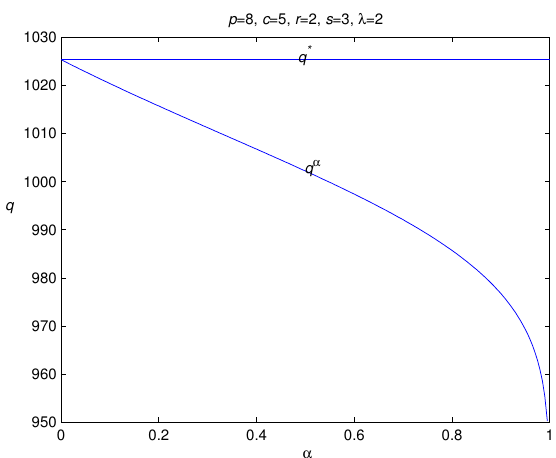
Figure 6. Optimal order quantities q ∗ and q α with different confidence levels α .